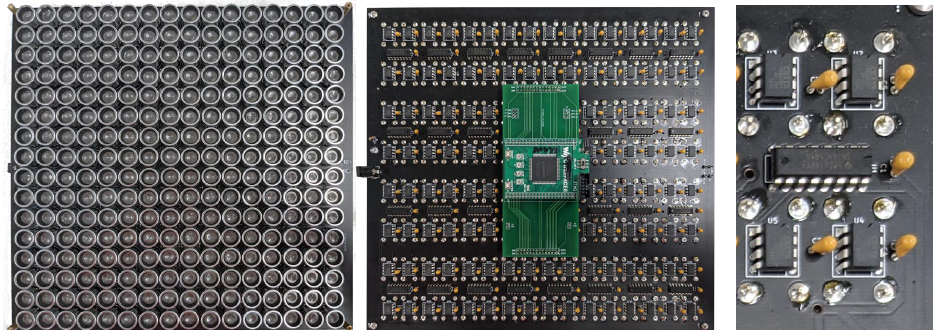
Figure 4. Ultrasonic array built with Through-hole components and emitters of 16 mm diameter. Through-hole ultrasonic array. Left) transducers of 1.6cm diameter soldered directly on the PCB. Center) back the board with the shift-registers, drivers and decoupling capacitors. The FPGA board is connected ( Left ) transducers of 16 mm diameter soldered on the printed circuit board (PCB). ( Center ) back of through a expander board with no logic, just expanding the lines. Right) detailed view of a shift-register plus the board with the shift registers, drivers and decoupling capacitors. The FPGA board is connected drivers block. through an expander board. ( Right ) detailed view of a shift register